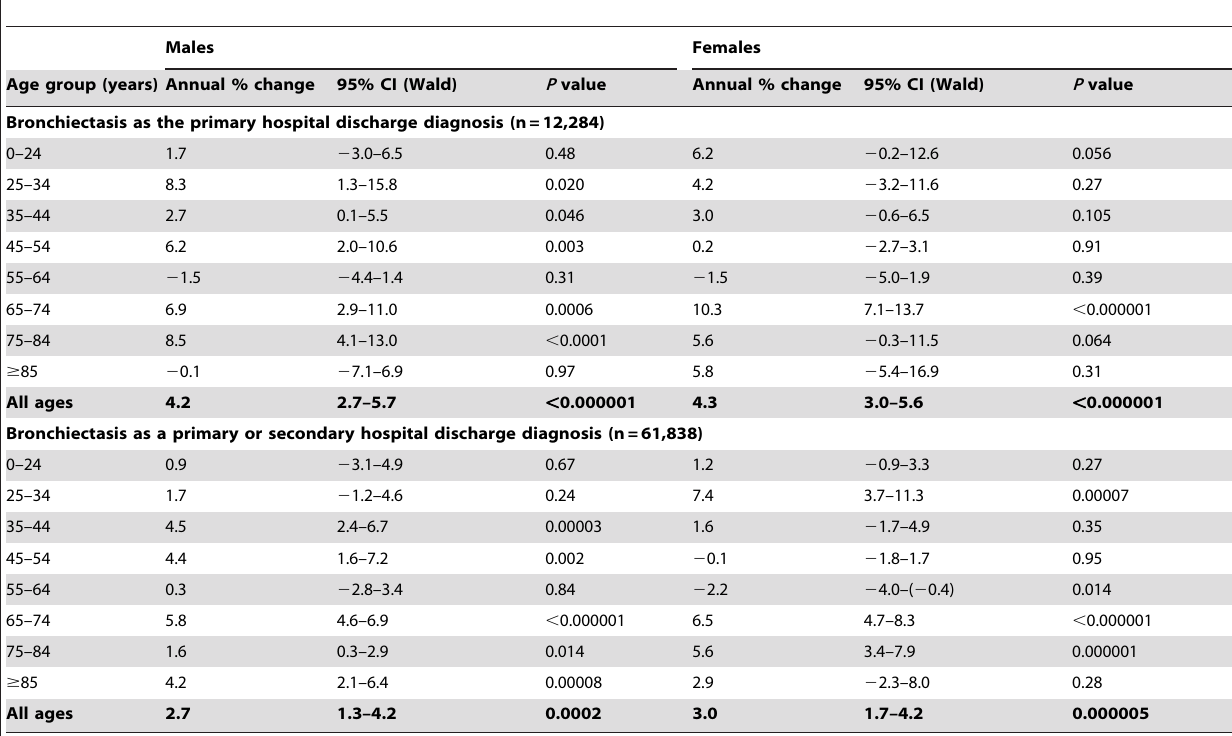
Table 1. Average annual percentage change of bronchiectasis as a hospital discharge diagnosis, stratified by sex, bronchiectasis diagnosis and age